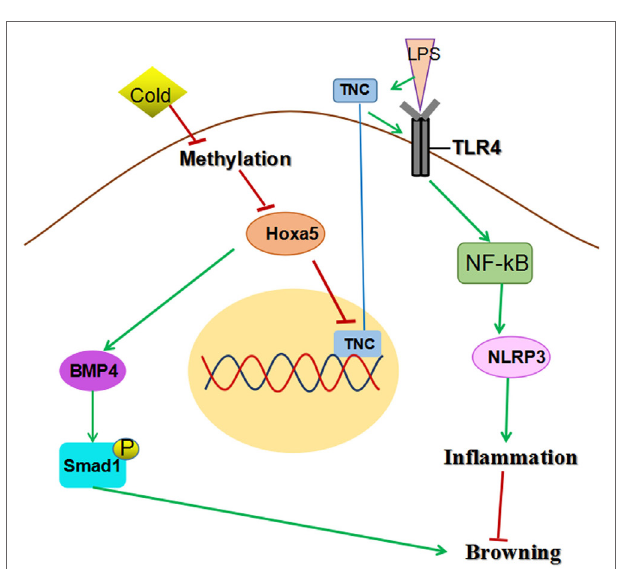
FigUre 9 | Homeobox a5 (Hoxa5) promotes white adipose tissue browning through reducing tenascin C (TNC)/toll-like receptor (TLR) 4/nuclear factor kappa B (NF- κ B) inflammatory signaling in mice. Hoxa5 promotes adipose tissue browning by activating BMP4/Smad1 signal and alleviating inflammation via inhibiting TNC/TLR4/NF- κ B